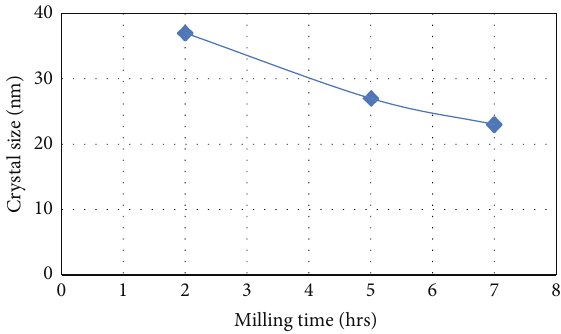
Figure 3: Variation of crystal size for the powders with milling